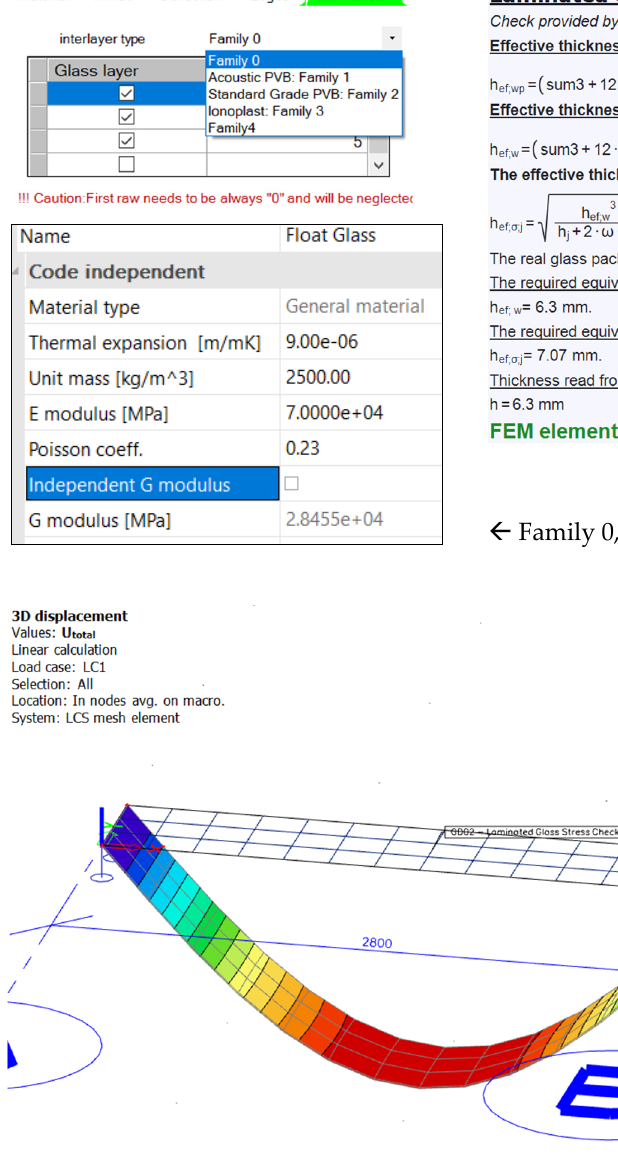
Figure 14. SCIA Engineer—addon for glass design. The value for the shear modulus in the formulas was obtained from linear interpolation of the given shear relaxation modulus inside of the Trosifol ® datasheet and manually entered into RF GLASS (Figure 15). Design approaches that are incorporated into the software Dlubal are in good agreement with the analytical Wölfel–Bennison approach [2] proving the accuracy of the Wölfel–Bennison approach with the FEM analysis of solid elements (Figure 16b).